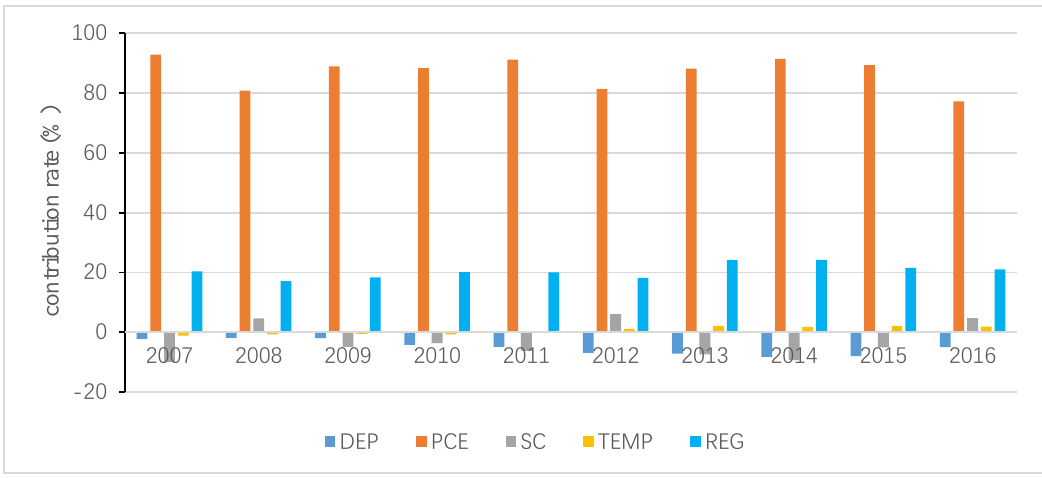
Figure 7. Decomposition result of rural residential energy consumption per capita (RRECP) by Gini coefficient.